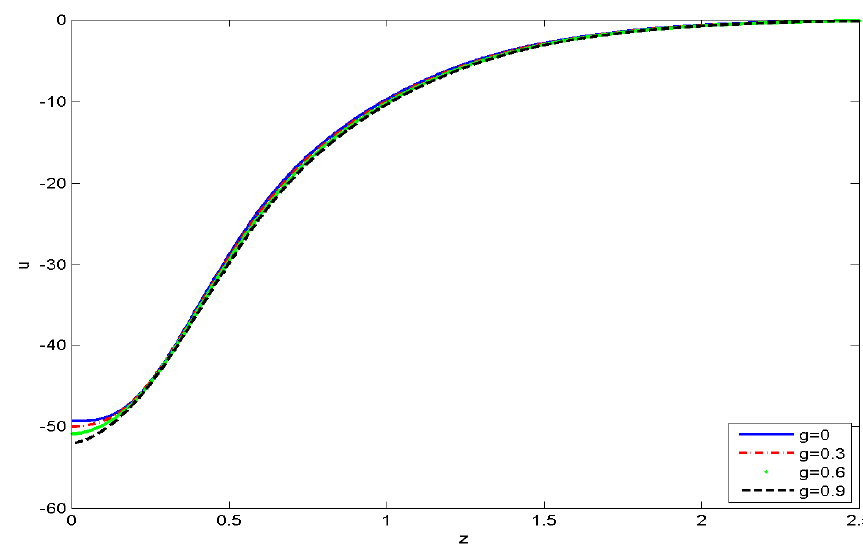
Figure 26. Horizontal displacement distribution u concerning z with gravity g.